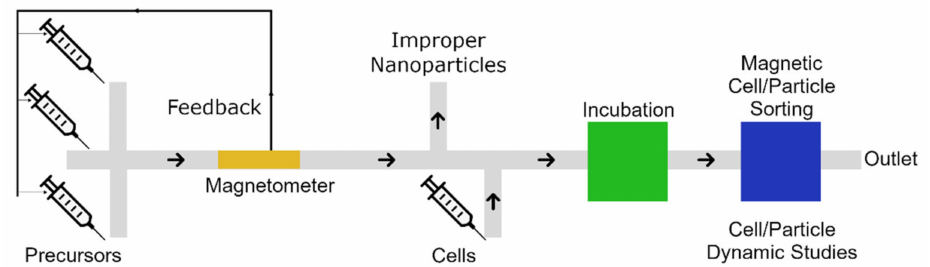
Figure 19. A schematic of a “lab-on-a-chip” device integrating particle synthesis, particle characteri- zation, magnetic labeling, and particle sorting sections on a single chip. In this design, the magnetic nanoparticles are synthesized and enter into the characterization section (yellow area). Based on the signal of the magnetometer a feedback signal is sent to the input controllers to tune the mag- netic nanoparticle characteristics. Then, after removing the improper nanoparticles, the synthesized magnetic nanoparticles are used to label the cells in an incubation chamber (green area). Next, the magnetically labeled cells are sorted on-chip (blue area) for biological